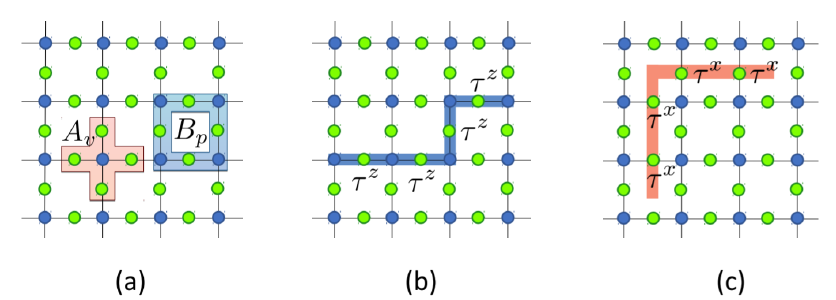
(cid:81) = σ x τ x and pla- v e (cid:51) v v e